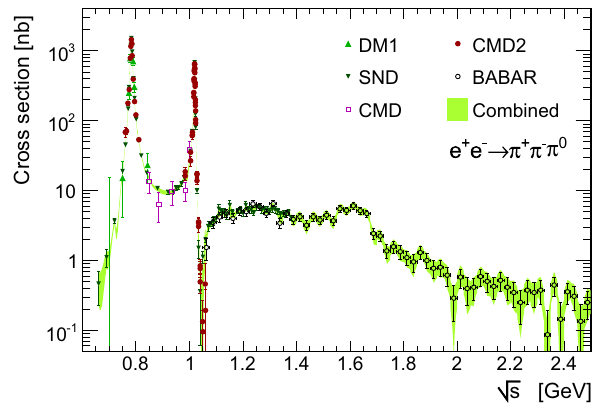
Fig. 4 Bare cross section of e + e − → π + π − π 0 versus centre-of-mass energy. The error bars of the data points include statistical and sys- tematic uncertainties added in quadrature. The green band shows the HVPTools combination within its 1 σ uncertainty